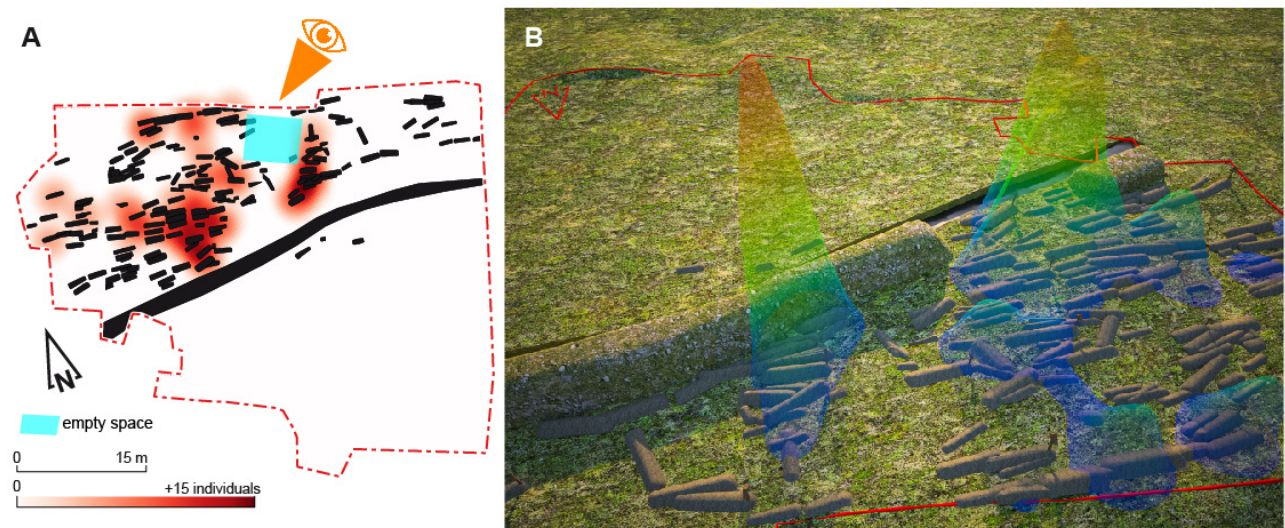
Figure 11. Concentration of all residual artefacts in the tombs. Heat map in plan ( A ) and 3D ( B ). The eye indicates the direction angle for the 3D restitution.